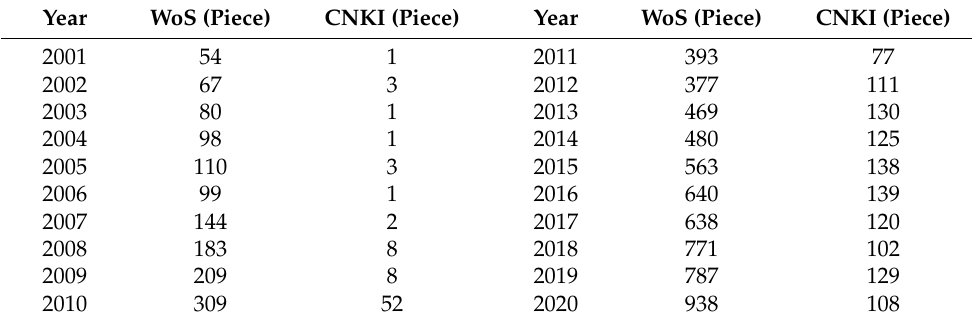
Table 1. Annual publication volume in 2001 − 2020.